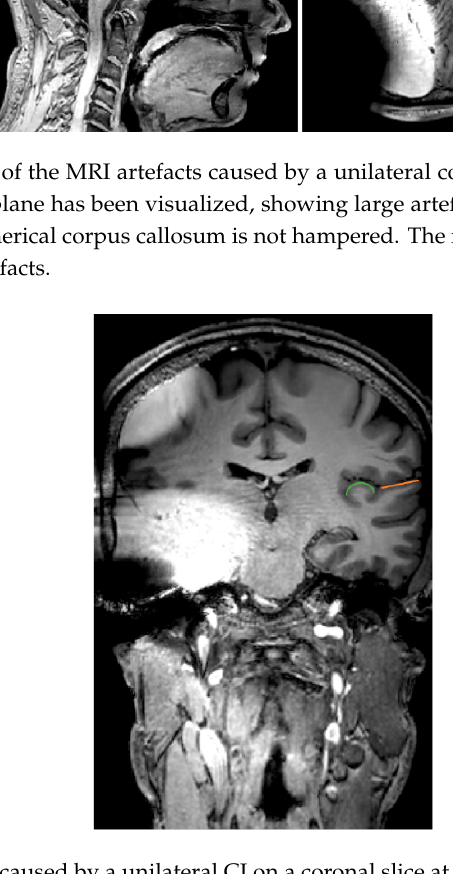
Figure 3. MRI artefacts caused by a unilateral CI on a coronal slice at the level of the auditory cortex. On the hemisphere contralateral to the device, the primary auditory cortex (Heschl’s gyrus) is depicted in green and the secondary auditory cortex (planum temporale) in orange .